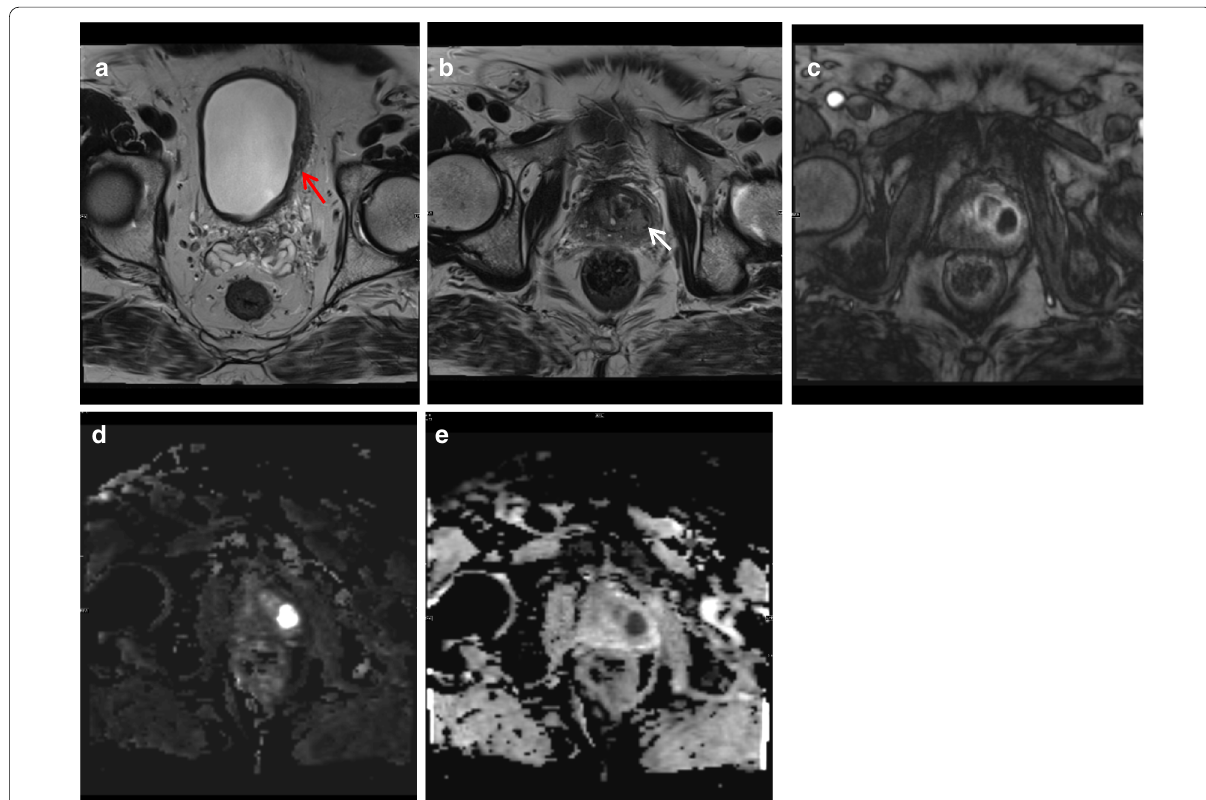
Fig. 7 Prostate abscess a , b Axial T2W images show left lateral bladder wall thickening (red arrow) and heterogeneous but predominantly low T2 signal in the left prostate (white arrow), respectively. c Post-contrast, the lesion demonstrates strong peripheral contrast enhancement and on DWI/ ADC in d , e , respectively, the central element of the left prostate lesion shows restricted diffusion with a very low ADC